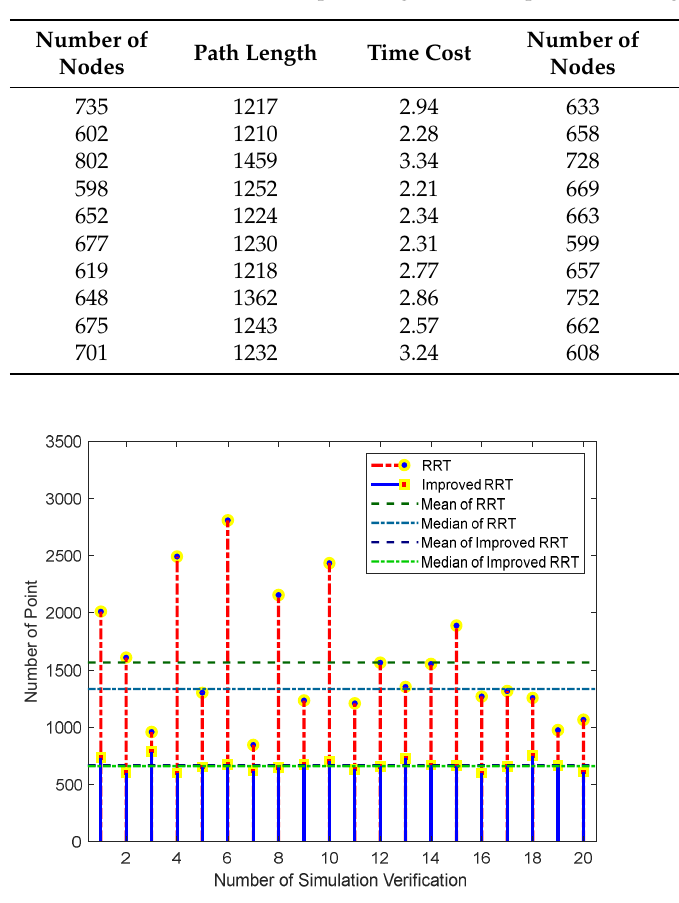
Table 3. Number of nodes and path length of the improved RRT algorithm.